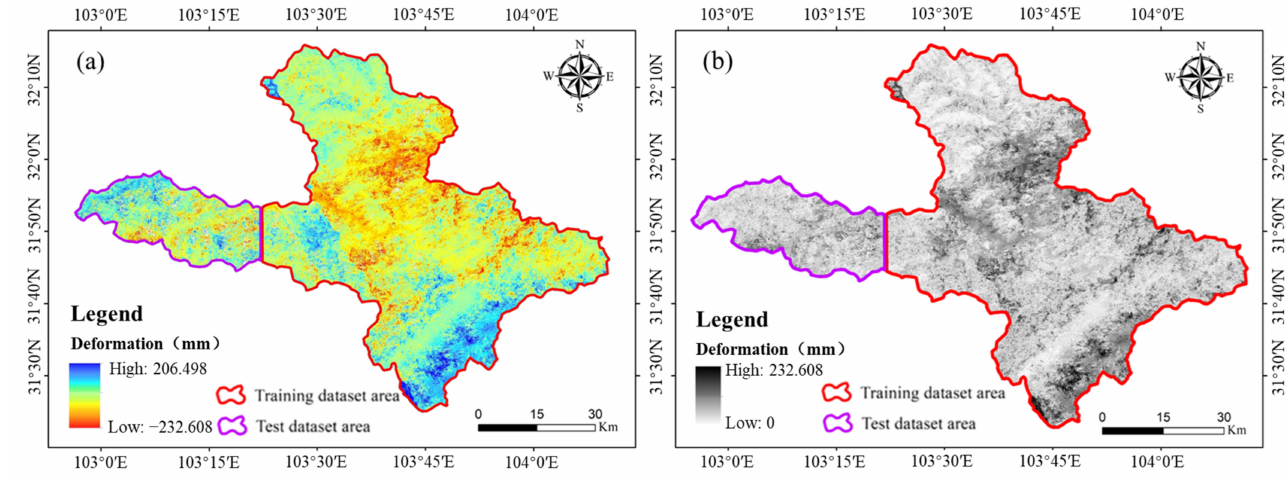
Figure 15. Division of training area and test area ( a ), and gray-scale conversion ( b ).